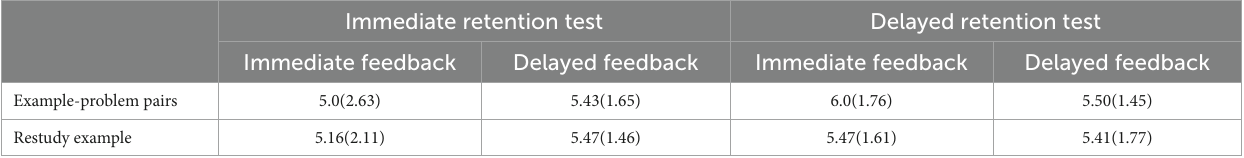
TABLE 6 The mental effort of different difficulties of retrieval feedback on